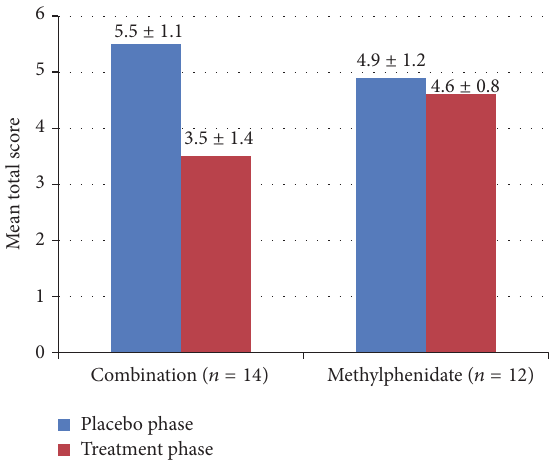
Figure 1: TSSC score in subjects treated with methylphenidate/ cetirizine, methylphenidate, or cetirizine compared to